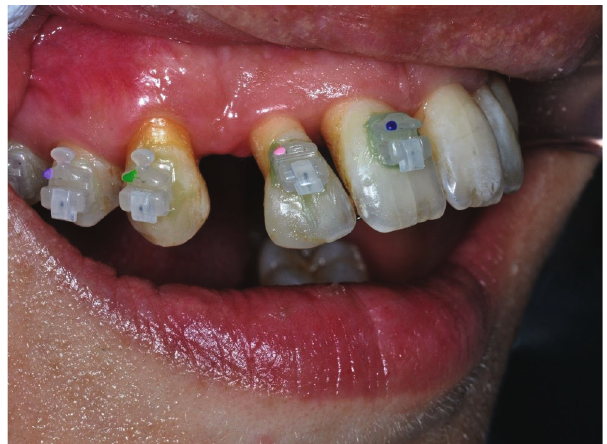
Figure 10: Clinical case: 3/4 view, orthodontic therapy.